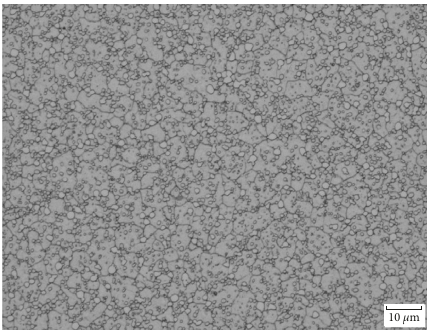
Figure 2: Light micrograph showing the microstructure of the Vanadis 6 steel after SZT at − 140 ° C for